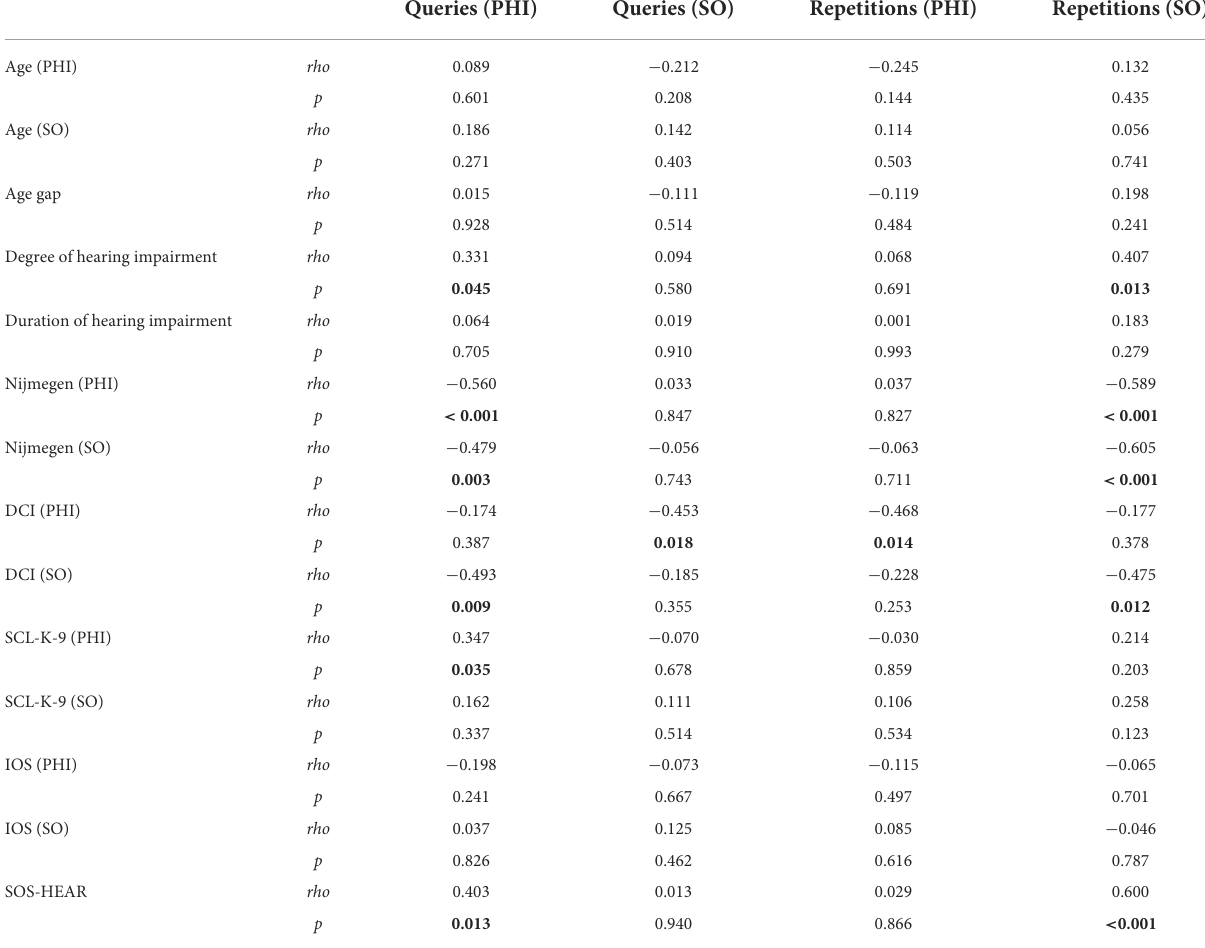
TABLE 5 Correlation of verbal interaction with demographic data and questionnaires of spouses ( N = 37). Queries (PHI) Queries (SO) Repetitions (PHI) Repetitions